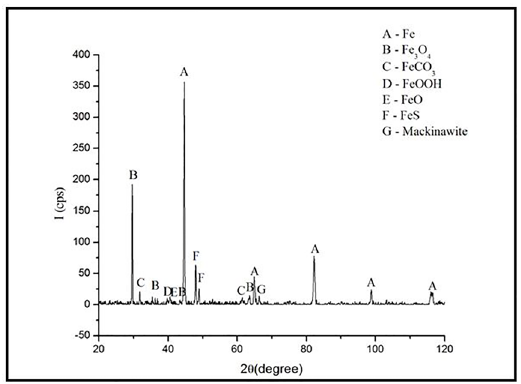
Figure 8. XRD spectrum of the metal surface, after 60 days of immersion in a biphasic